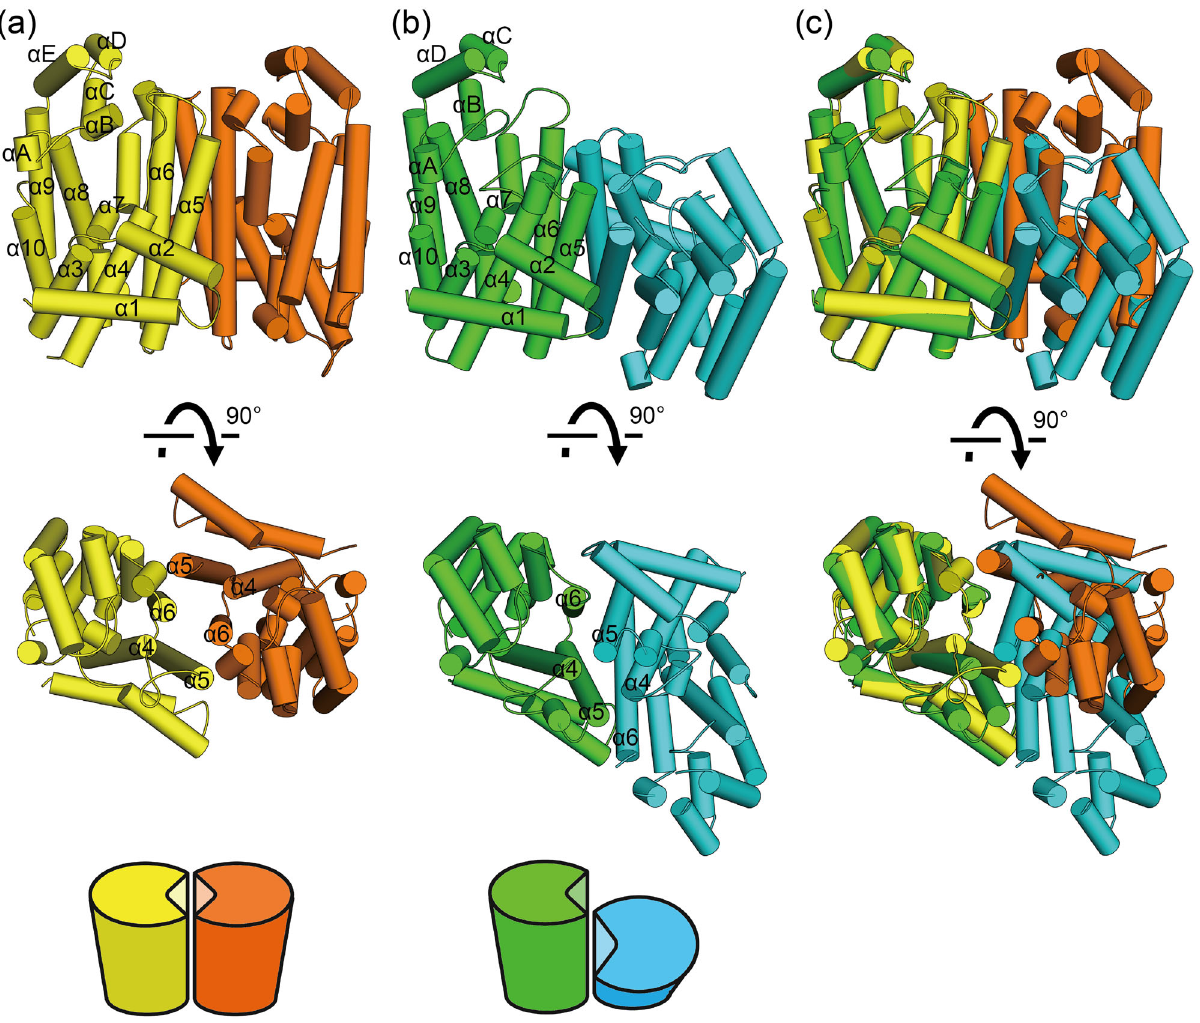
Fig. 3 Dimeric structures of EuTPT3 and EuFPS1. Graphic representations of overall structures of EuTPT3 ( a ) and EuFPS1 ( b ) are shown. The helices are represented as cylinders. Chain A and B of EuTPT3 are colored in yellow and orange, respectively. Chain A and B of EuFPS1 are colored in green and cyan, respectively. Simpli fi ed models of the dimeric architectures are shown in bottom. c Superimposed structures of EuTPT3 and EuFPS1 based on chain